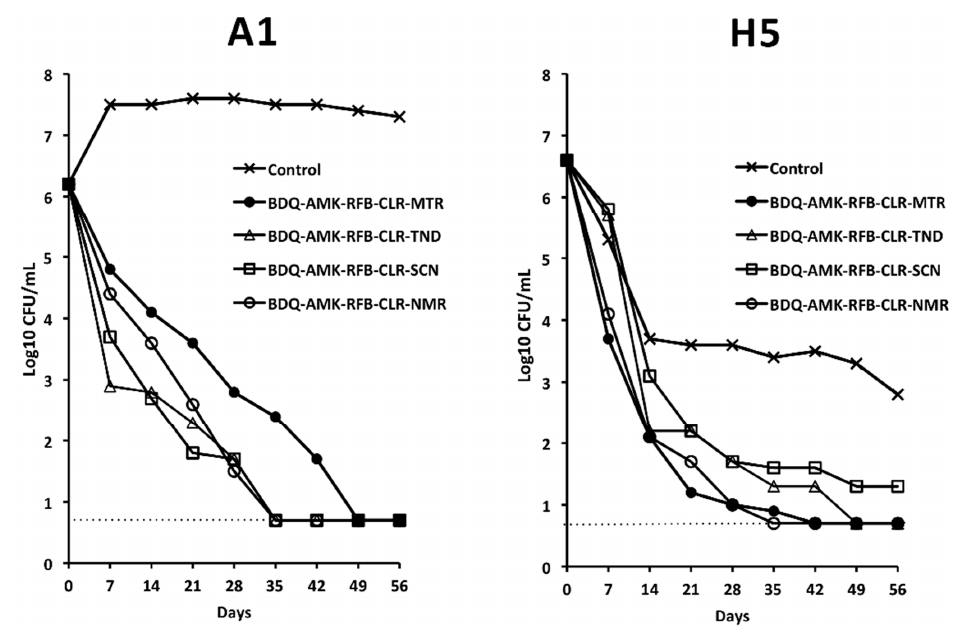
Figure 8. Activity against A1 and H5 cells of BDQ-AMK-RFB-CLR-MTR, without or with substitution of MTR with TND, SCN or NMR. Dashed lines indicate the limit of detection (5 of MTR with TND, SCN or NMR. Dashed lines indicate the limit of detection (5 CFU/mL). A CFU/mL). A representative experiment out of two is shown. representative experiment out of two is shown. Table 1. Survival of A1 and H5 cells to various drug combinations, as estimated by regrowth in liquid medium using the MGIT 960 system. Day-to-positivity (DTP) values are indicated. Samples inoculated in MGIT 960 tubes refer to samples of Figure 8.